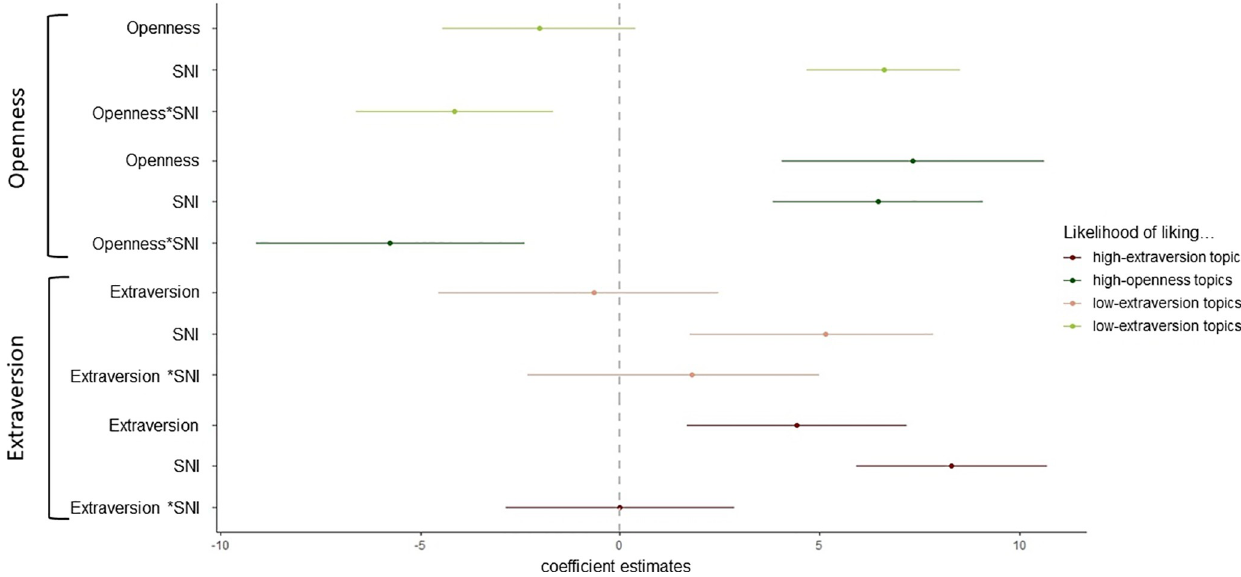
Fig 1. Coefficient estimates for the regression analyses with SNI and openness/extraversion on Facebook liking behavior. An overview of the coefficient estimates with the CIs for the four regression analyses is as follows: (1) likelihood of liking low-openness topics = Openness � SNI (2) likelihood of liking high- openness topics = Openness � SNI (3) likelihood of liking low-extraversion topics = Extraversion � SNI (4) likelihood of liking high-extraversion topics = Extraversion � SNI. Regarding the aim of Study 2, it should be noted that all four regression analyses revealed a conditional effect of SNI, substantiating that SNI drives OSN users to like what others in OSNs like. Furthermore, the depicted coefficient estimates for the interactions show that there is only partial support for the idea that SNI moderates the effect of the Big Five personality traits on OSN behavior.